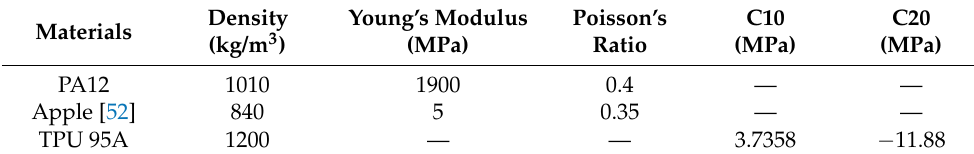
Figure 2. Strain–stress curve of the tensile test and fitting using the Yeoh model (TPU95A). Table 1. Mechanical property parameters of materials.